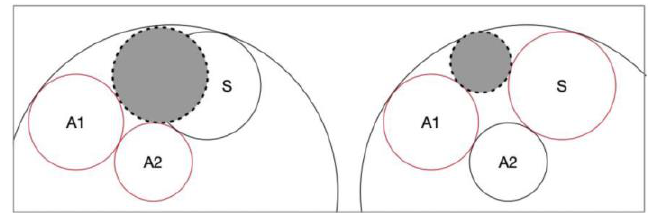
Figure 9. Testing circle overlaps with another placed